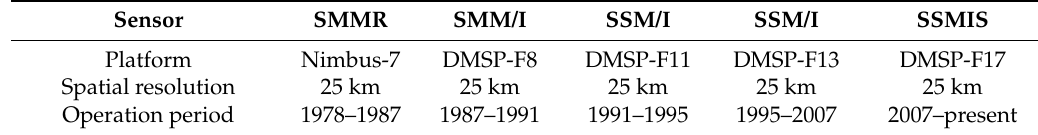
Table 1. Satellite sensors for measuring sea ice concentration since